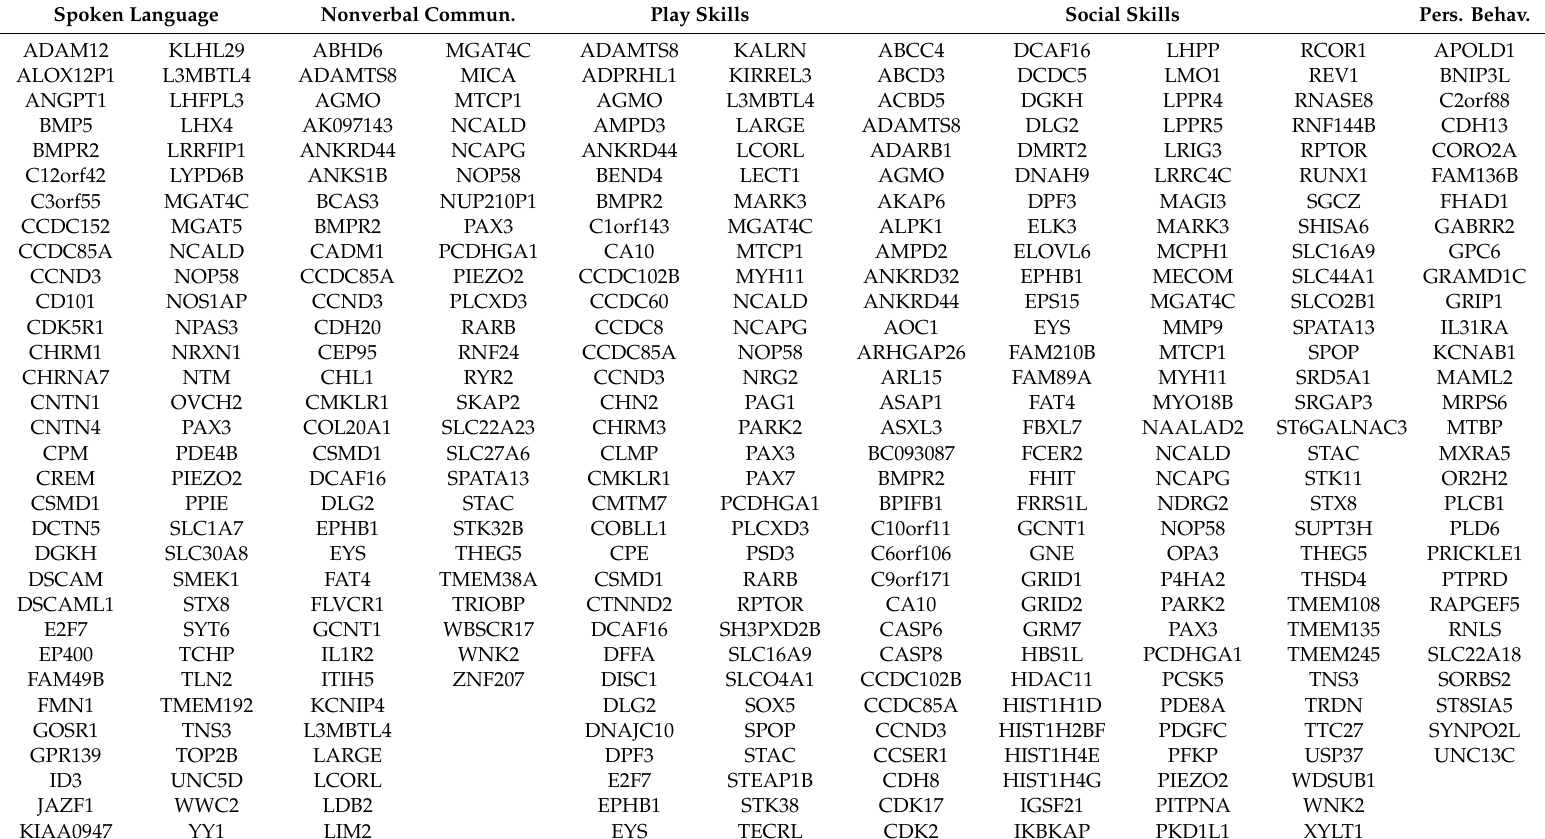
Table 1. Summary of genes associated with QTNs for each trait across all twin